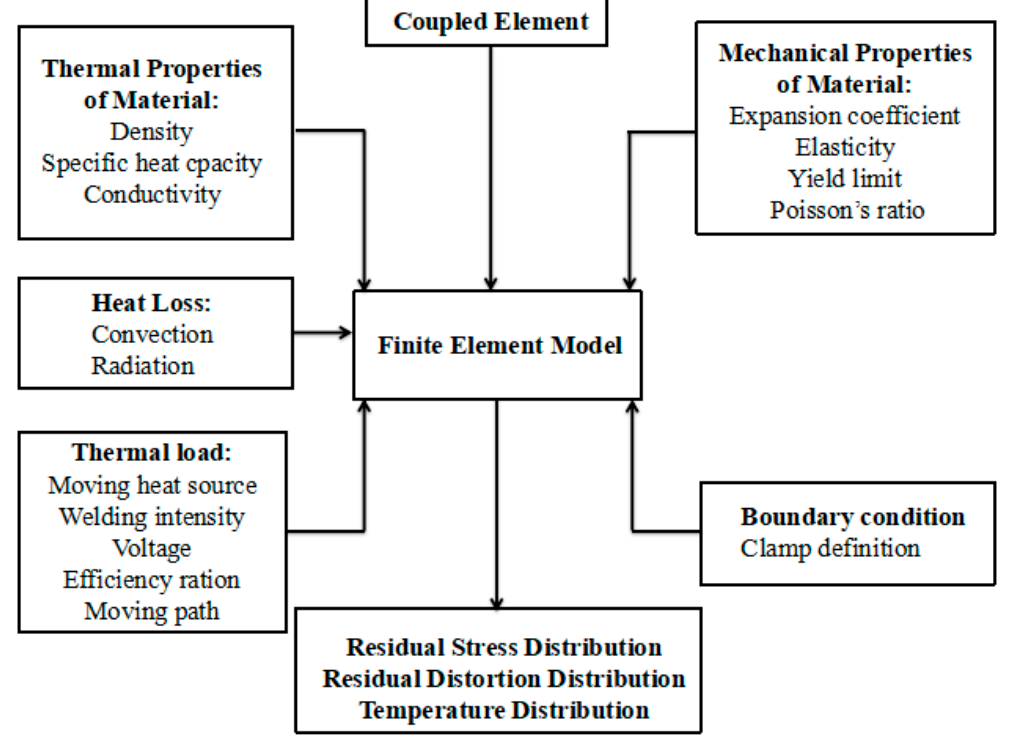
Figure 6. Flow diagram of the direct coupled thermo-elasto-plastic approach.